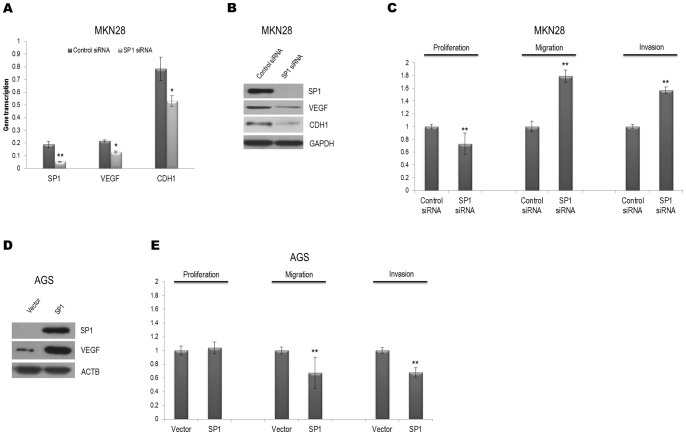
The transfection of the intestinal-type cell lines, MKN28 and AGS, with SP1 siRNA or SP1 plasmid controls cell proliferation, cell migration, and invasion.A) MKN28 cells were transfected with SP1 siRNA or control siRNA. Total mRNA was extracted to determine the expression of endogenous VEGF and CDH1 using qRT-PCR. HPRT was used as a control. *, P<0.05; **, P<0.01. B) Western blot data reveal that SP1 siRNA causes the knockdown of SP1 and reduces the expression of both VEGF and CDH1 in MKN28. GAPDH was used as a control. C) Cell proliferation, migration, and invasion were assessed after transfection with SP1 or control siRNA in MKN28. **, P<0.01. D) Western blot data demonstrated that SP1 protein levels were increased by transfection with the SP1 plasmid. ACTB served as the control in AGS. E) Cell proliferation, migration, and invasion assays were performed after transfection with the SP1 plasmid or a control vector in AGS. **, P<0.01.